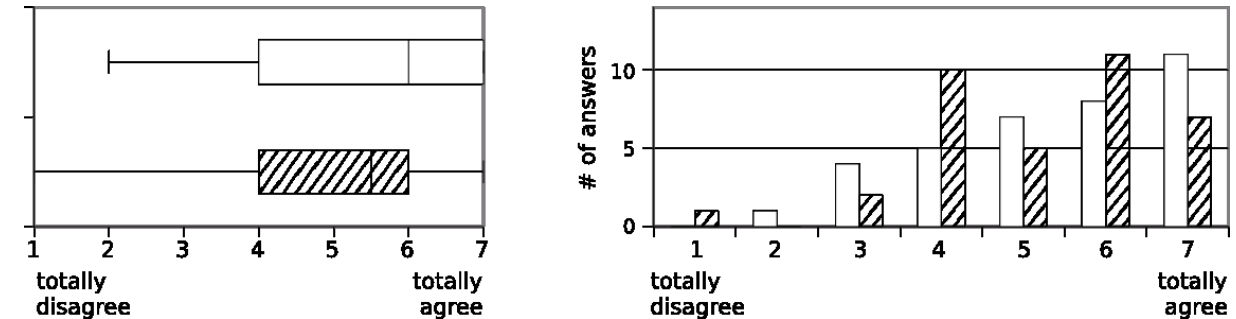
Figure 5. Ability to use and learn xprompt. White bars: the handling of xprompt is uncomplicated. Cross-hatched bars: I was able to learn the usage of xprompt in a short time.